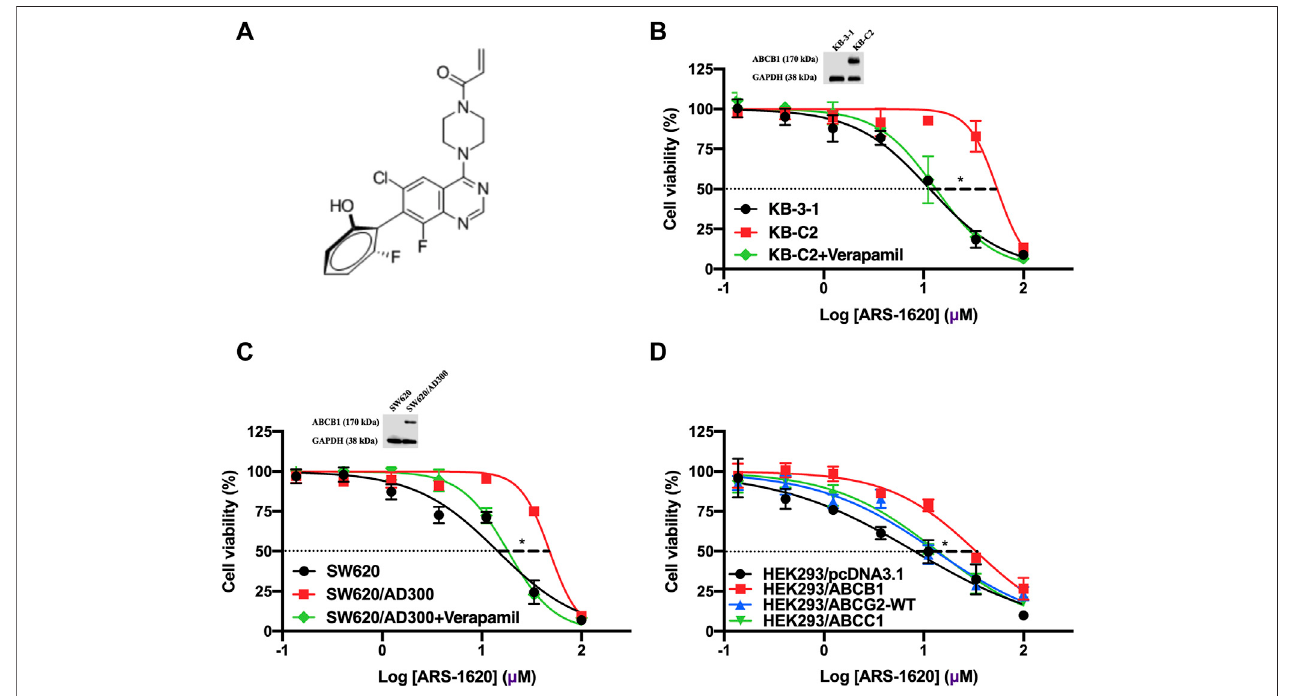
FIGURE 1 | Cytotoxicity curves of ARS-1620 in parental and ABCB1-overexpressing cancer cells. (A) Chemical structure of ARS-1620. (B, C) KB-3-1, KB-C2, SW620, and SW620/Ad300 cells. The corresponding ABCB1 expression level were also displayed. (D) HEK293/pcDNA3.1, HEK293/ABCB1, HEK293/ABCG2 and HEK293/ABCC1 cells. Verapamil of 3 μ M was used as positive control. Data are displayed as mean ± SD with three independent assays. * p < 0.05.